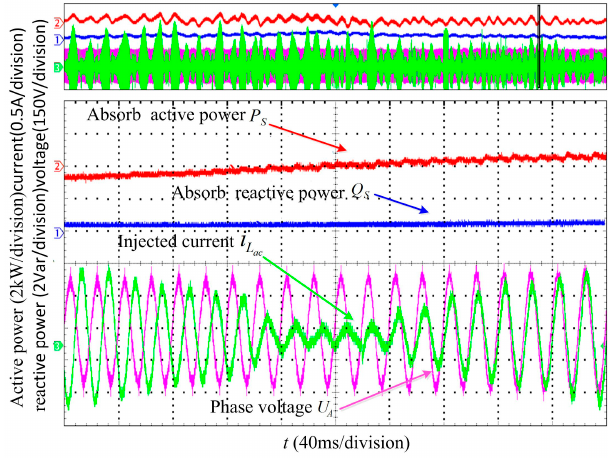
Figure 17. Experimental results during active and reactive power regulation.